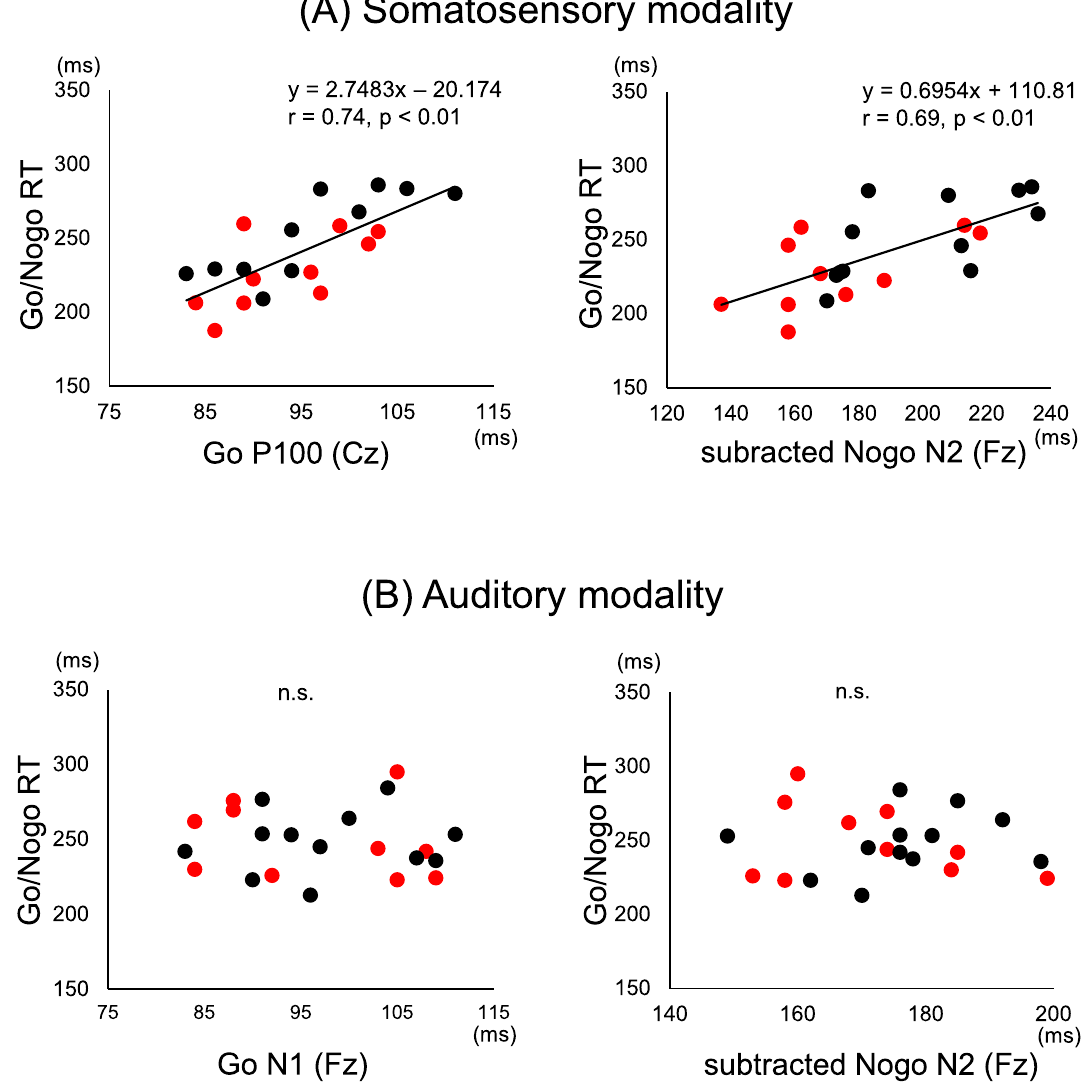
Figure 3. Correlations in somatosensory and auditory modality. Correlations between Go/Nogo RT and the latency of Go P100 and N1 as well as the subtracted Nogo N2 components in ( A ) the somatosensory modality and ( B ) the auditory modality. The black and red circles show the T&F and baseball groups,